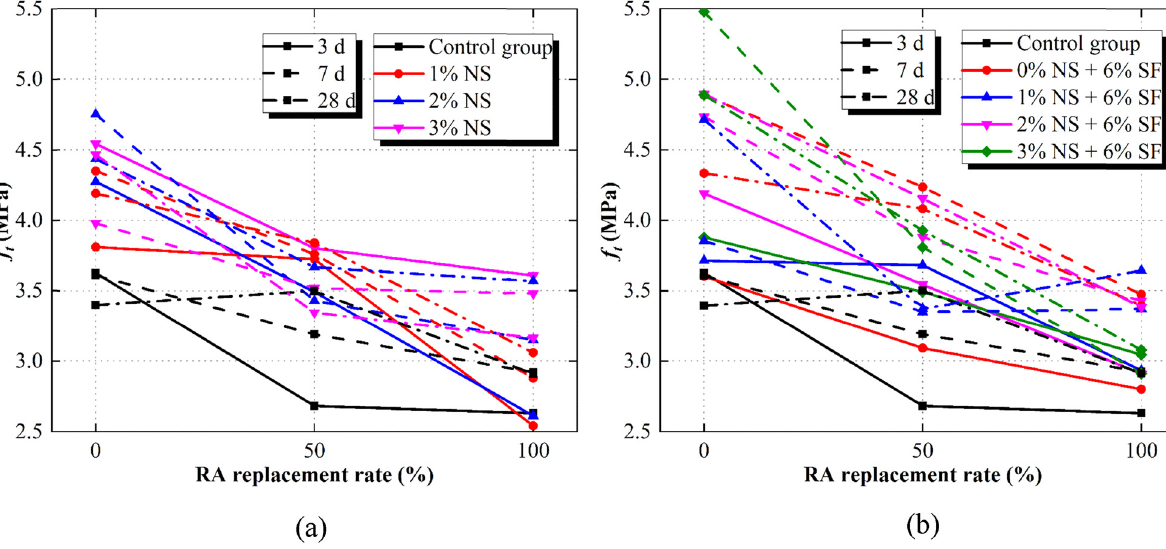
Figure 11: E ff ect of RA replacement percentage on the split tensile strength: ( a ) NSRAC and ( b )